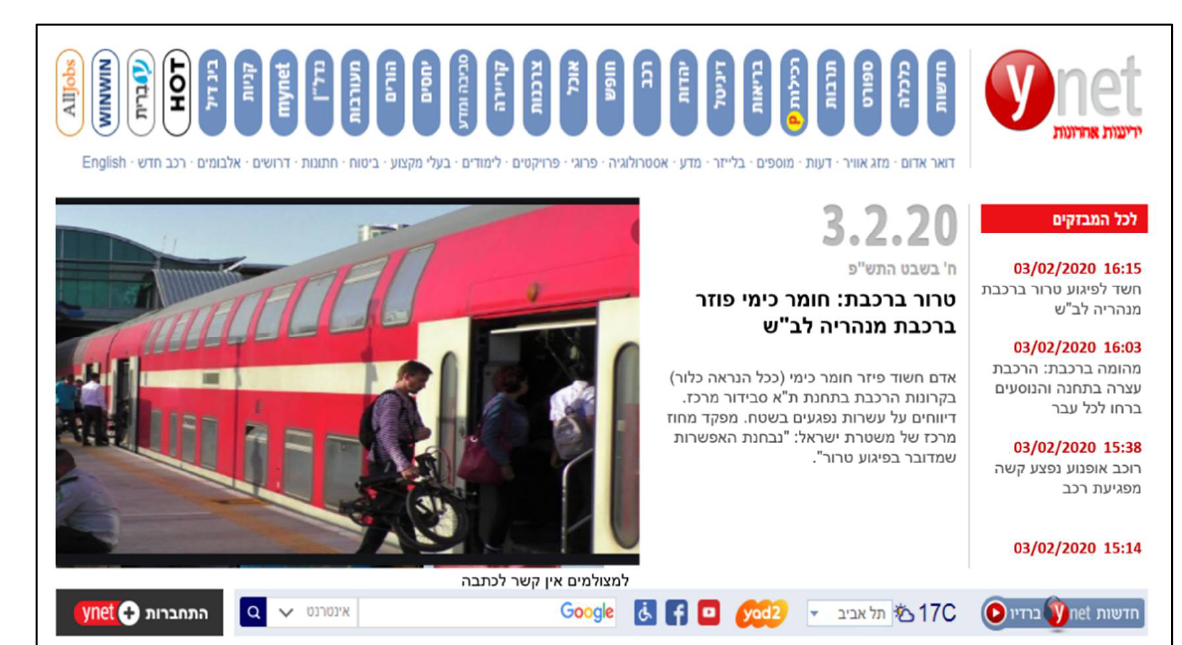
Figure A1. Screenshot of the mock classical news report for the chemical scenario.